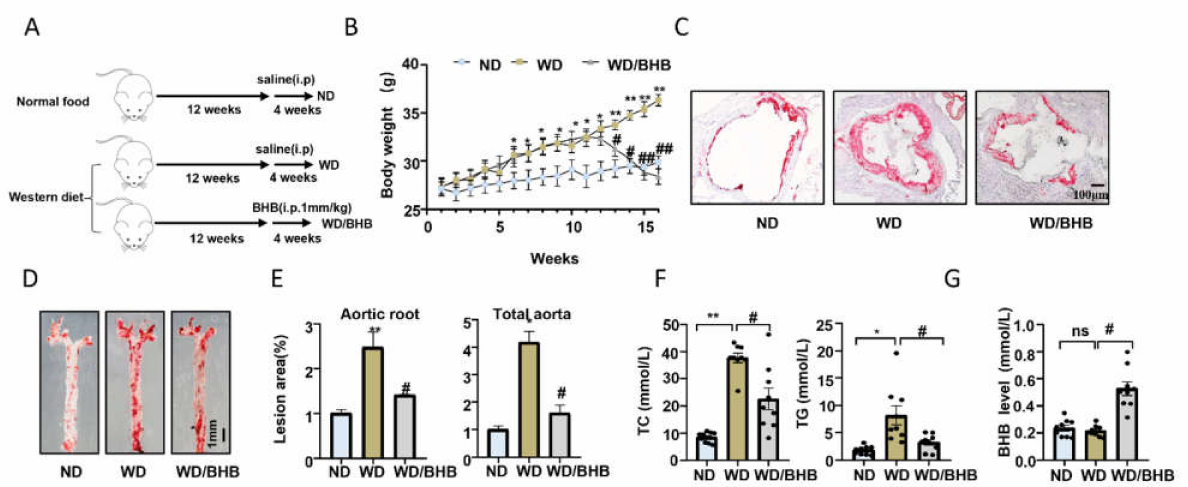
Figure 5. BHB is atheroprotective in ApoE − / − mice fed a Western diet. ( A ) ApoE − / − mice were fed a Western diet for 16 weeks and administered the vehicle or BHB (1 mm/kg daily, i.p.) in the final 4 weeks of the diet. ( B ) Body weight of the mice. ( C ) Representative images of the cross-sections of the aortic root stained with Oil Red O. Scale bar, 100 µ m. ( D ) Representative images of the whole aorta stained by Oil Red O. Scale bar, 1 mm. ( E ) Quantification of the cross-sections of the lesion area in the aortic root and whole aorta (n = 6). ( F ) Total cholesterol (TC) and triglycerides (TG) in the serum from the mice (n = 9). ( G ) BHB level in the serum from the mice (n = 9). Data are represented as means ± SEM. * p < 0.05, ** p < 0.01 vs. ND mice; # p < 0.05, ## p < 0.01 vs. WD mice, ns